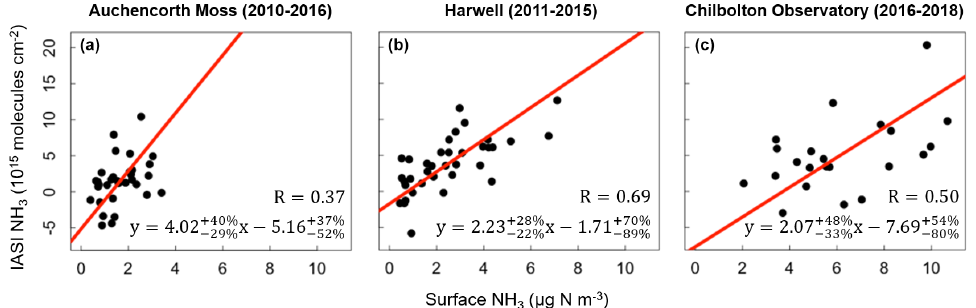
Figure 3. Assessment of IASI NH 3 with ground-based NH 3 at UK EMEP sites. Points are monthly means from IASI and the surface sites Auchencorth Moss (a) , Harwell (b) , and Chilbolton Observatory (c) . The red line is the SMA regression. Values inset are Pearson’s correlation coefficients and regression statistics. Relative errors on the slope and intercept are the 95% CI. Locations of UK EMEP sites are indicated in Fig.